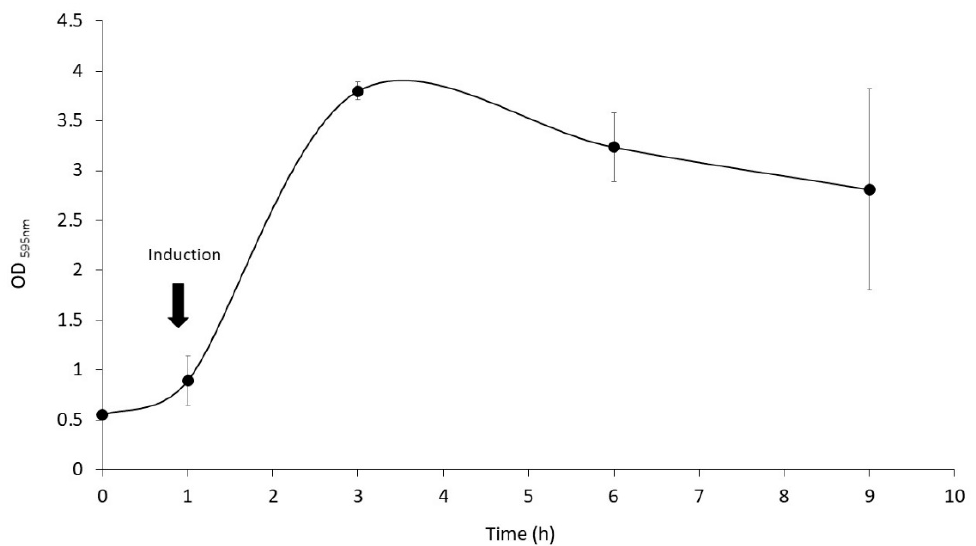
Figure 6 . Kinetics for the fermentation in a 1.5 L bioreactor. The LTB-RBD Wuhan antigen was produced in batch cultures grown in a 1.5 L jar fermenter (ez-Control system model 56,156, Applikon Biotechnology) containing 1 L of LB medium plus antibiotics. pH was maintained at 7.0 ± 0.5, O 2 saturation was kept above 40% by culture stirring (400–600 rpm) and aeration (0.5–1.5 L/min). The temperature was held at 37 °C.